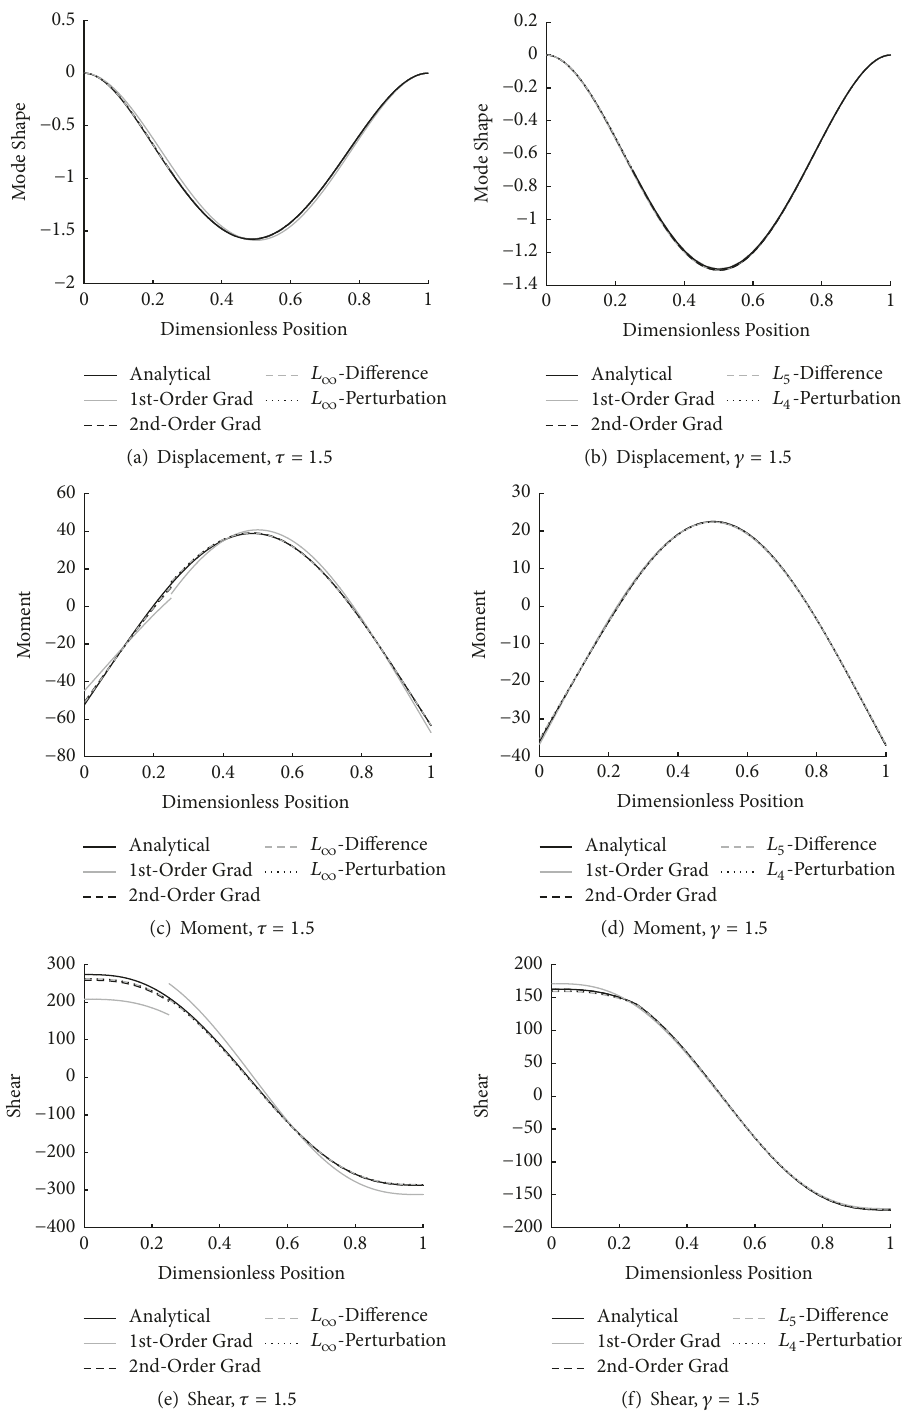
Figure 4: Mode shape displacement, moment, and shear for CC boundary